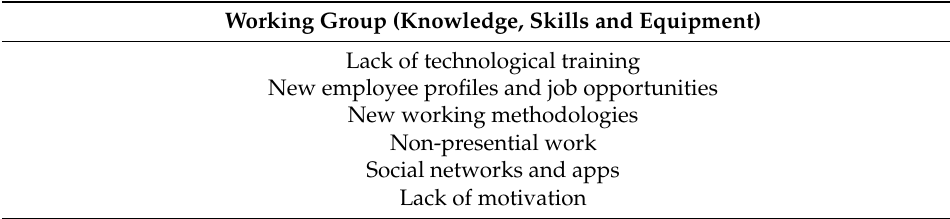
Table 3. BOT working group. Source: own elaboration.